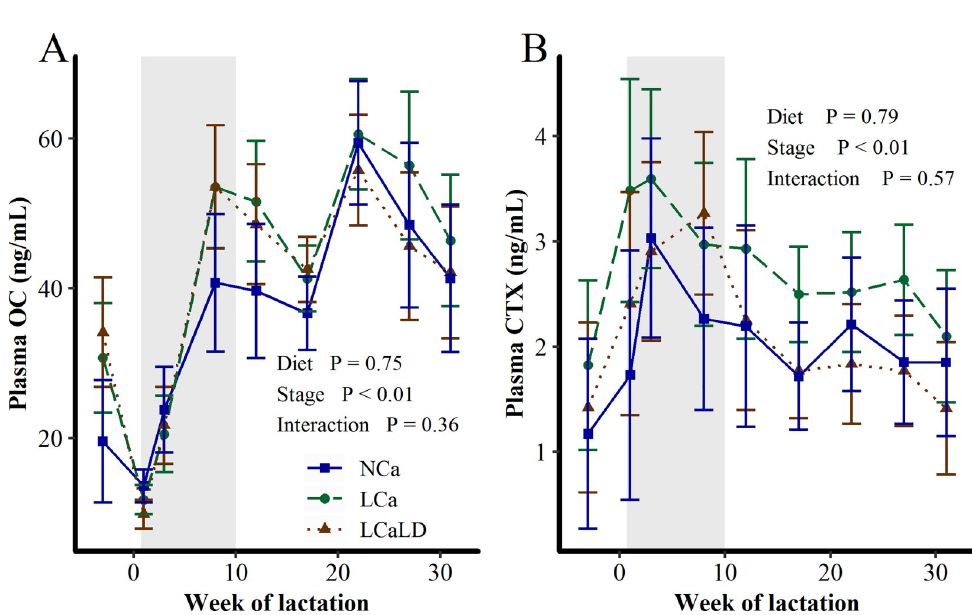
Fig 3. Effect of transient variation in dietary Ca content and the DCAD on A) plasma OC concentration and B) plasma CTX concentration between 3 weeks before calving and 31 weeks of lactation. NCa = normal Ca (4 cows), LCa = low Ca (5 cows), LCaLD = low Ca and low DCAD (5 cows). Gray background specifies the period during which cows were fed differentiated diets according to the treatments. Data were analyzed using a generalized linear mixed model with repeated values using PROC GLIMMIX in SAS [35]. Covariance matrix: FA for plasma OC content and UN for plasma CTX content. Vertical bars represent standard errors of the mean.